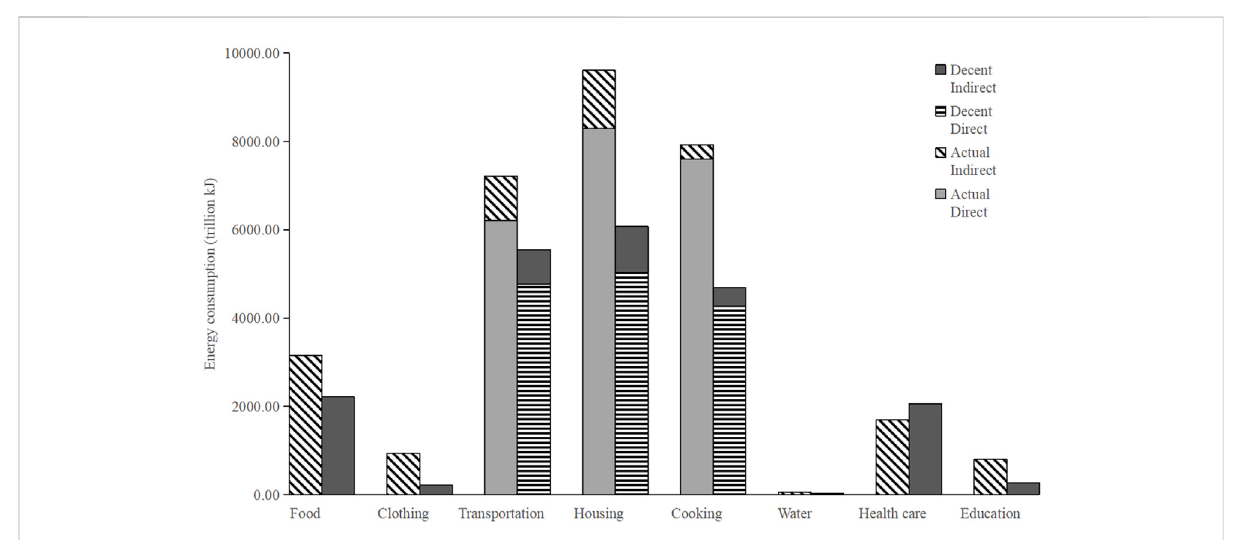
FIGURE 2 Energy consumption by household consumption categories under actual situation and